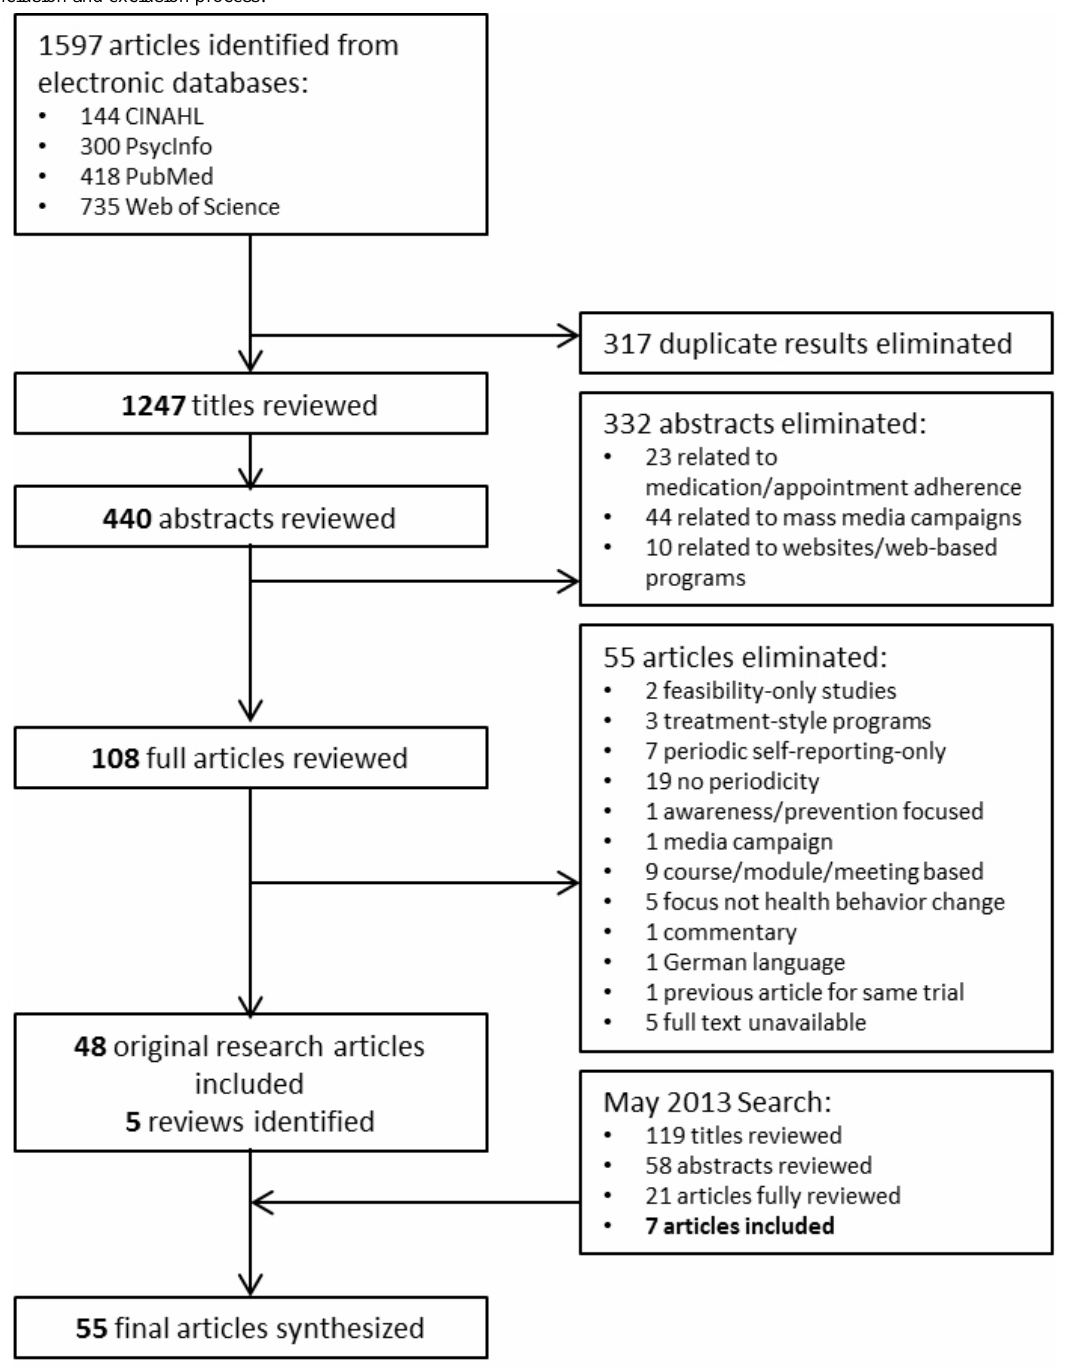
Figure 1. Inclusion and exclusion